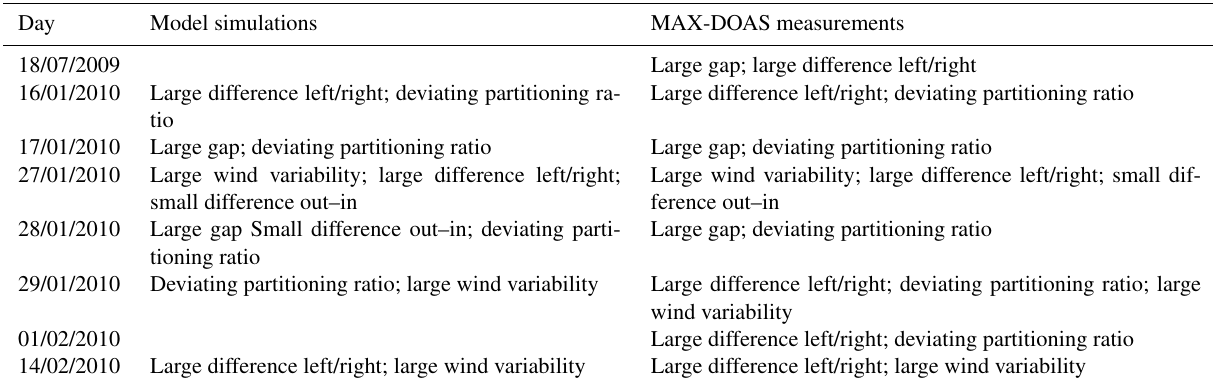
Table 3. Overview of days with several problems.